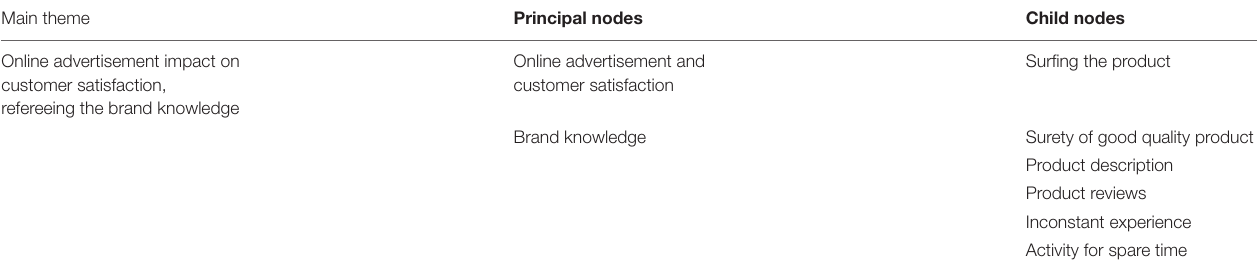
TABLE 1 | Main theme, principal nodes, and child